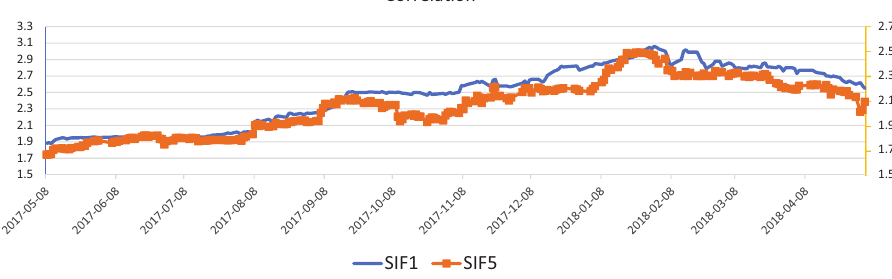
Figure 4. Practical correlation between 2 Romanian